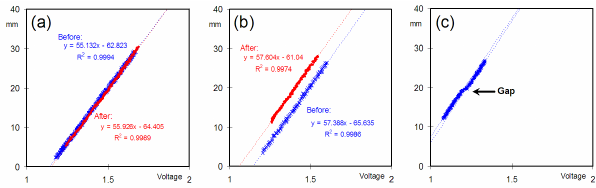
Fig. 4 Examples of (a) successful sensor calibration, and calibration failures due to (b) a difference in the pre- and post-experiment offset and (c) a sensitivity gap (non-linearity) during the calibration.